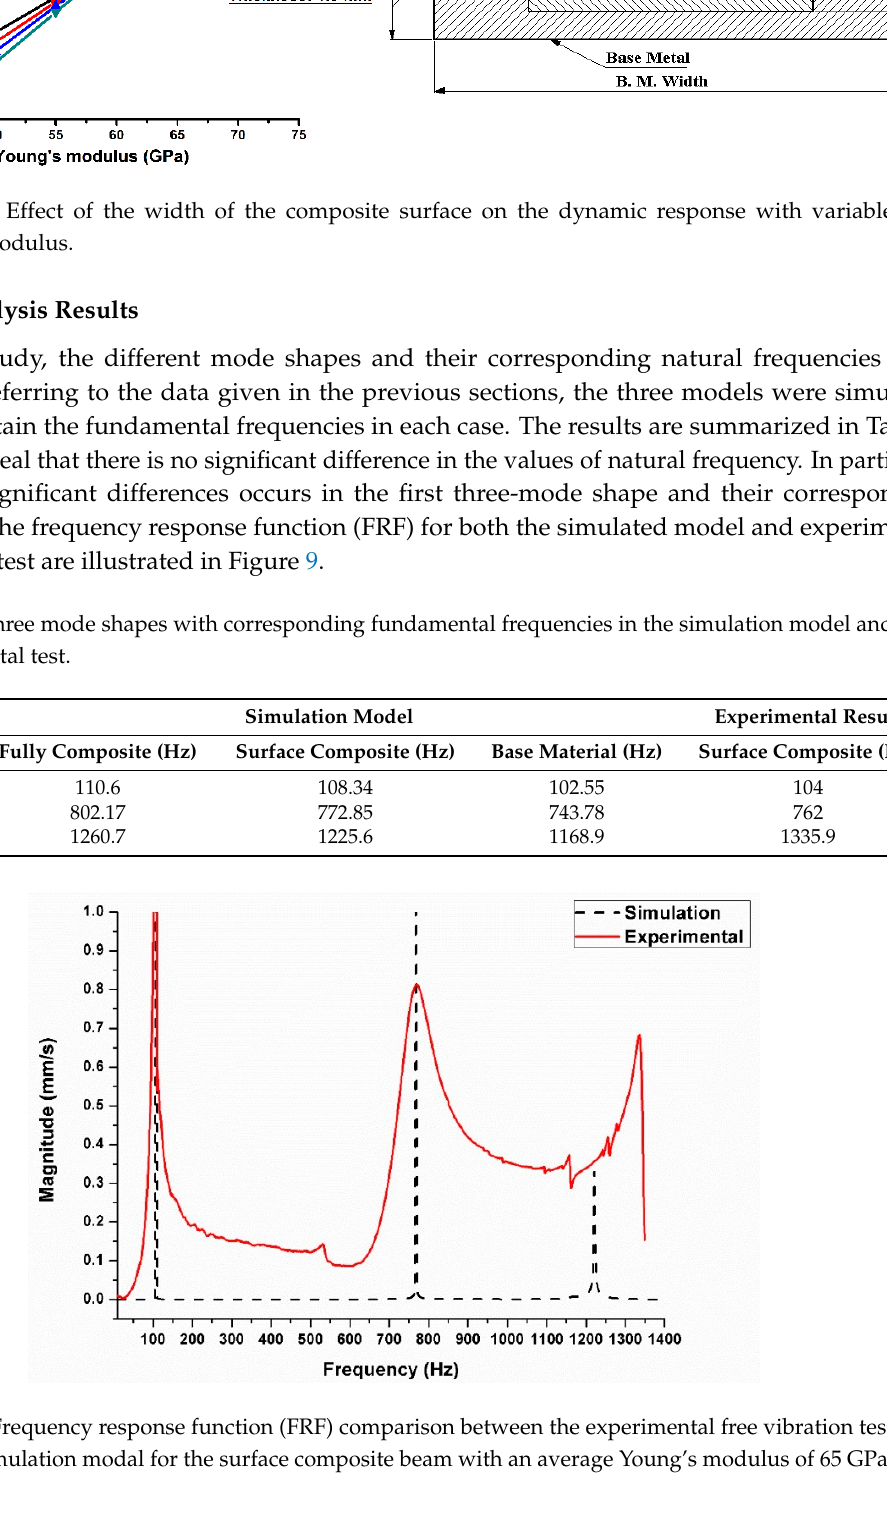
Figure 7. Effect of geometry on the dynamic properties for the fully composite beam, which was determined in a parametric study.